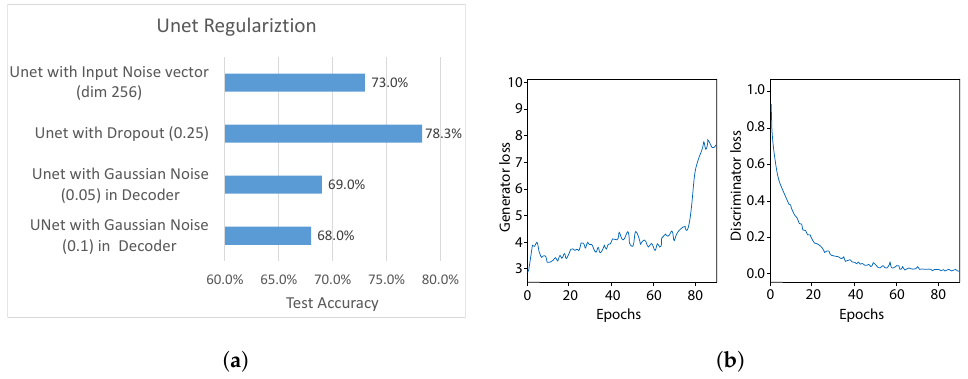
Figure 19. Effect of UNet regularization. ( a ) Experiments of various regularization methods in UNet (generator). ( b ) Comparison between generator and discriminator losses during training, when using dropout in UNet and L 1 loss β =